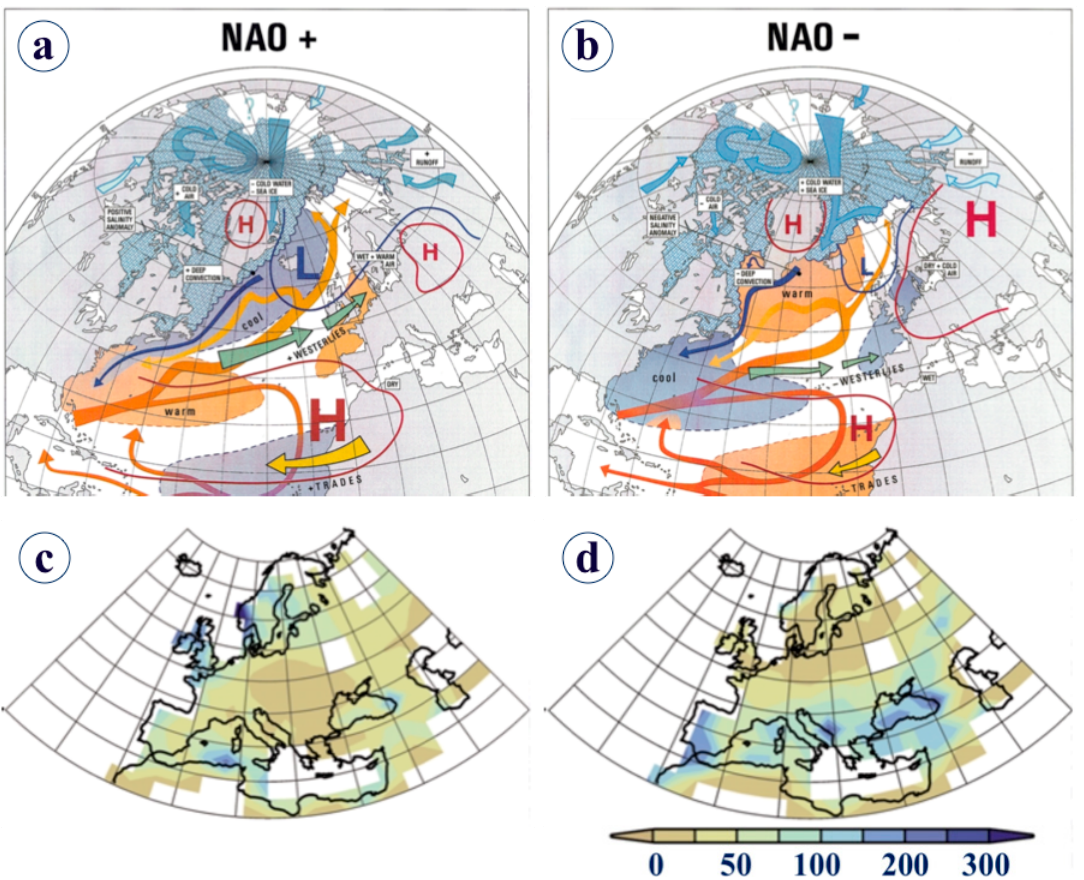
Figure 9. Atmospheric and oceanic circulation ( a , b ), and precipitation ( c , d , mm) for the two modes of the NAO index. In ( a , b ) sea-ice extension, cold, and warm SST are plotted in cyan, blue, and orange, respectively. The thickness of arrows represents the strength of the winds. Data from [41,95,96].